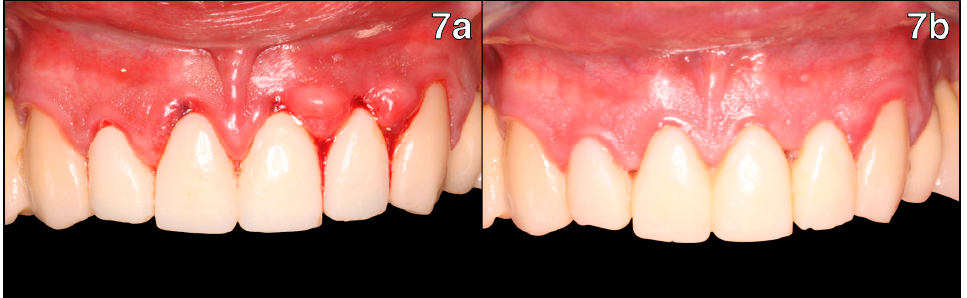
Figure 7. Temporization and periodontal tissue healing of new preparations: ( 7a ) adaptation of new temporary crowns; ( 7b ) review appointment 2 months after temporary crowns placement; optimal periodontal healing can be observed.